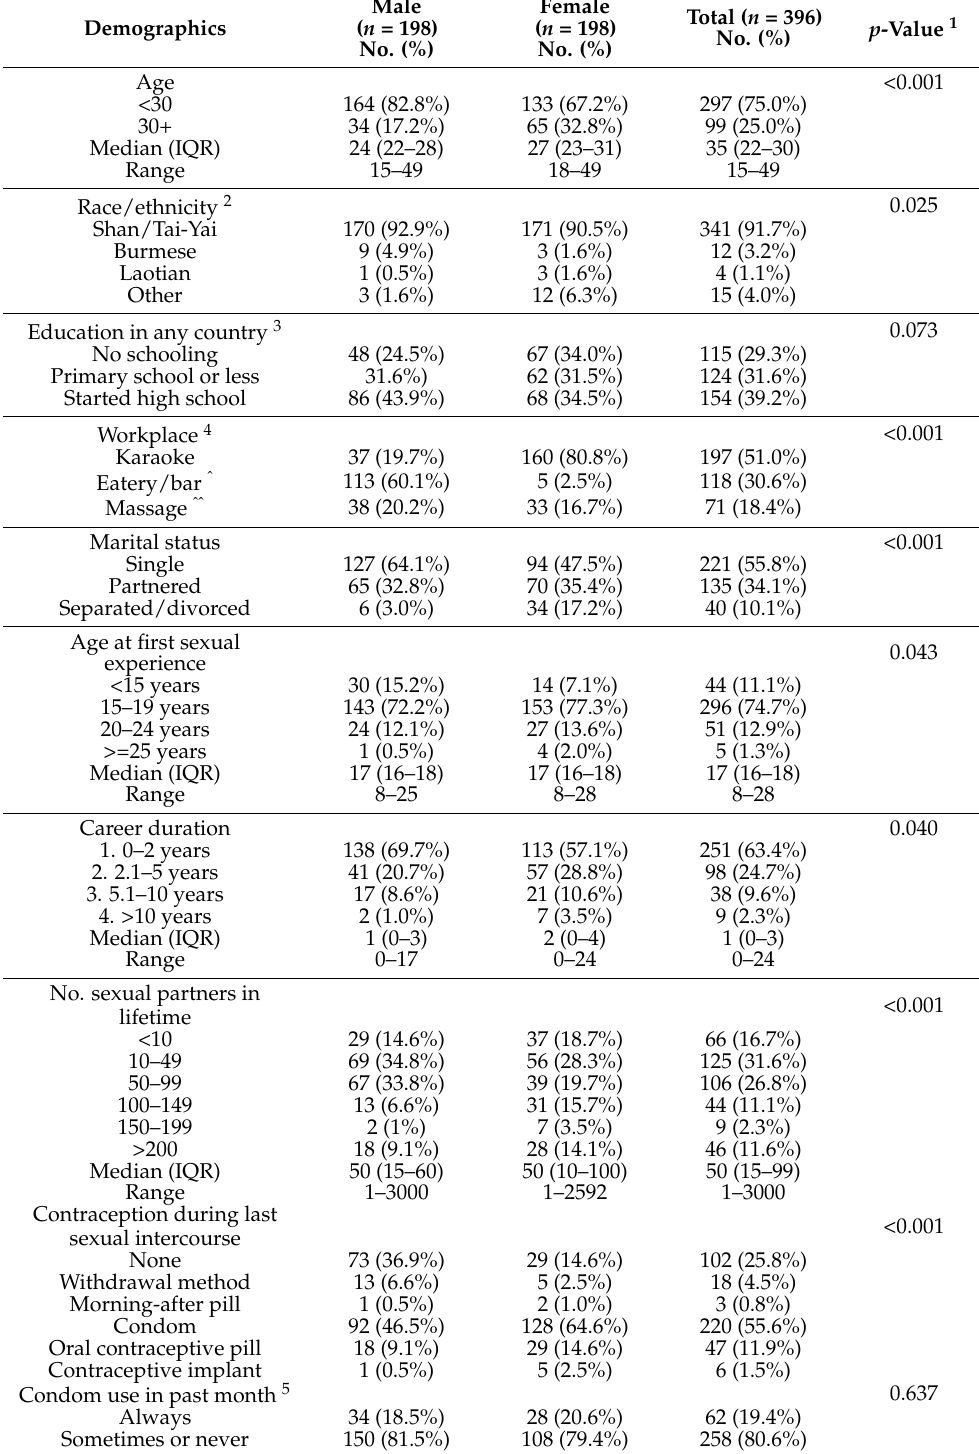
Table 1. Demographics of sample